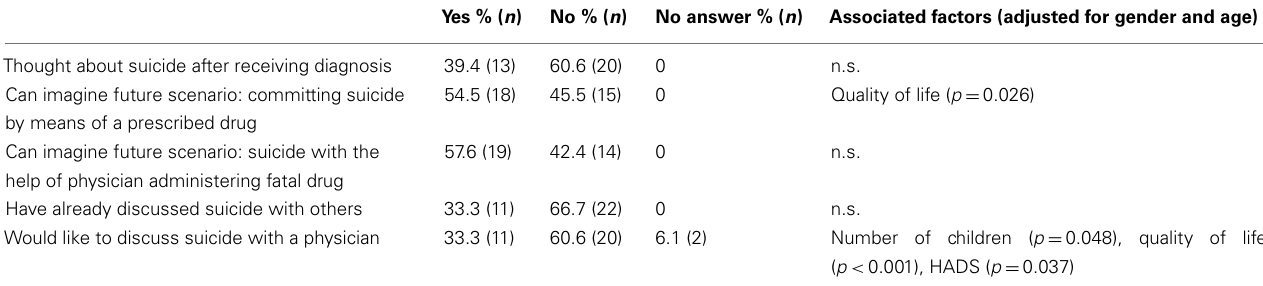
Table 2 | Patient suicidality; n.s., no significant effect.